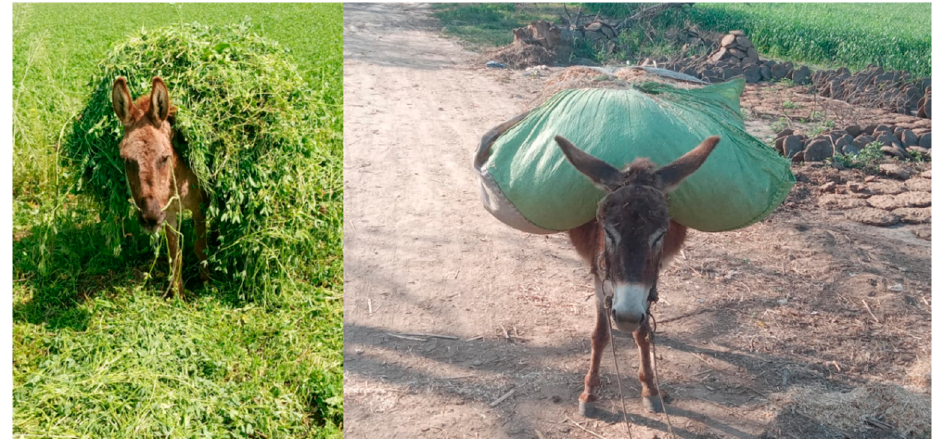
Figure 1. Working donkeys involved in the transportation of agricultural load (Lucerne and wheat straw) in central Punjab-Pakistan. Photo: Syed Saad Ul Hassan Bukhari.